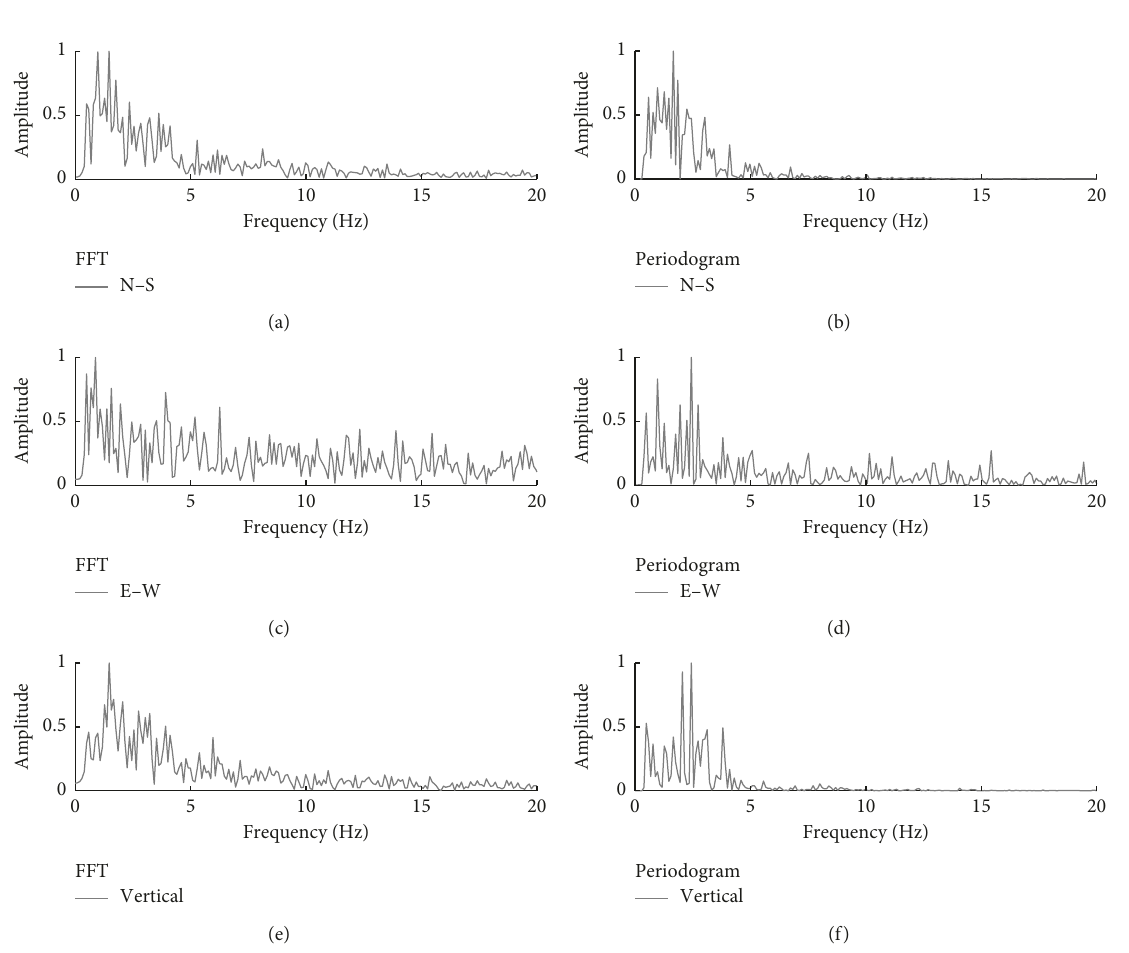
Figure 11: Dynamic frequencies in terms of normalized FFT and